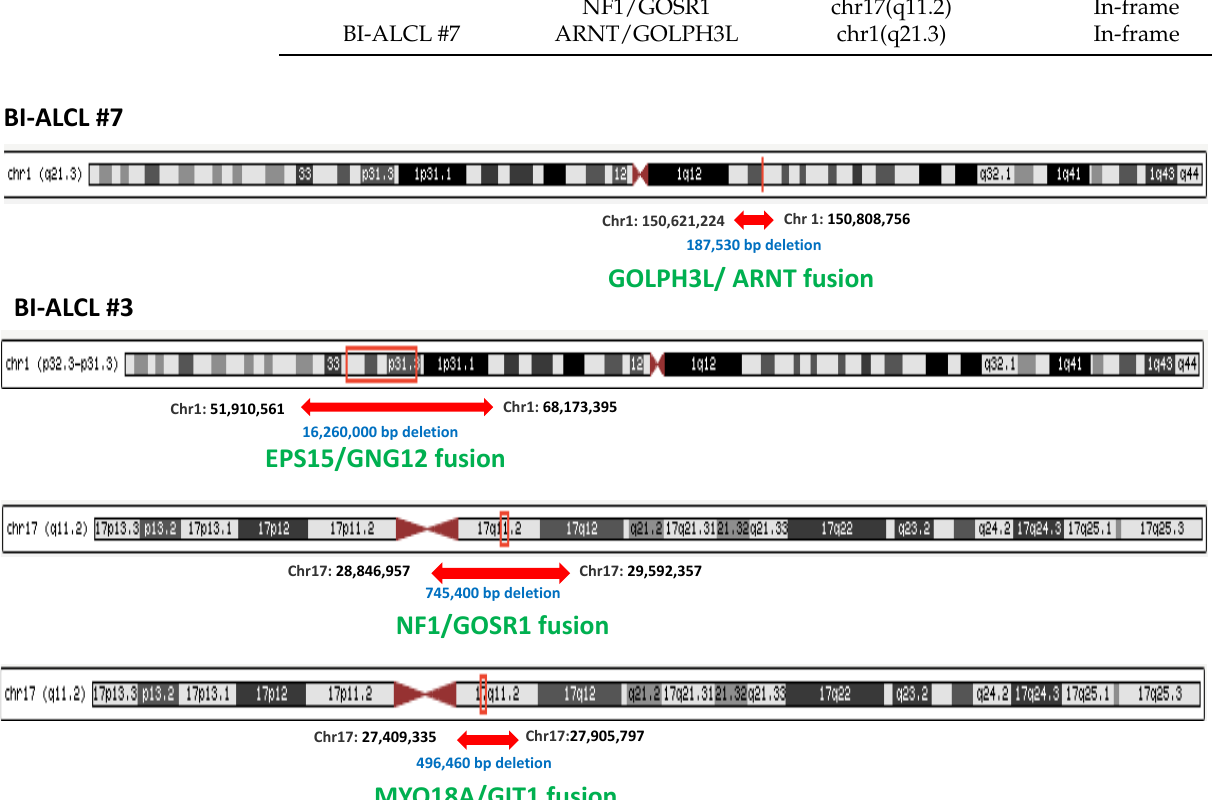
Figure 1. Intrachromosomal deletions in two cases of BI-ALCL resulting in the generation of fusion transcripts. Of note, three out of the four RNA fusions occurred in the same sample (BI-ALCL#3), which was also found to display a complex karyotype (Figure 2) including a deletion of chromosome 20, as previously reported in 66% of BI-ALCLs [22]. Cells deficient in certain DNA repair pathways can still survive by compensating the defect using error-prone repair pathways, which in turn favor additional mutations or chromosomal rearrange- ments, increasing genomic instability. To test the hypothesis that the high rate of genomic alterations found in our BI-ALCL sample could be related to mutations in genes involved in DNA damage repair and cell cycle control, we performed a targeted NGS with 26 cancer susceptibility genes, which revealed a germline variant of uncertain significance V1027L of the mismatch repair gene MSH6 (allele variant 49.80%). These data reveal that fusion transcripts are infrequent in both cALCL and BI-ALCL, and that in the latter they may occur as a consequence of intra-chromosomal deletions, possibly associated with genomic instability.